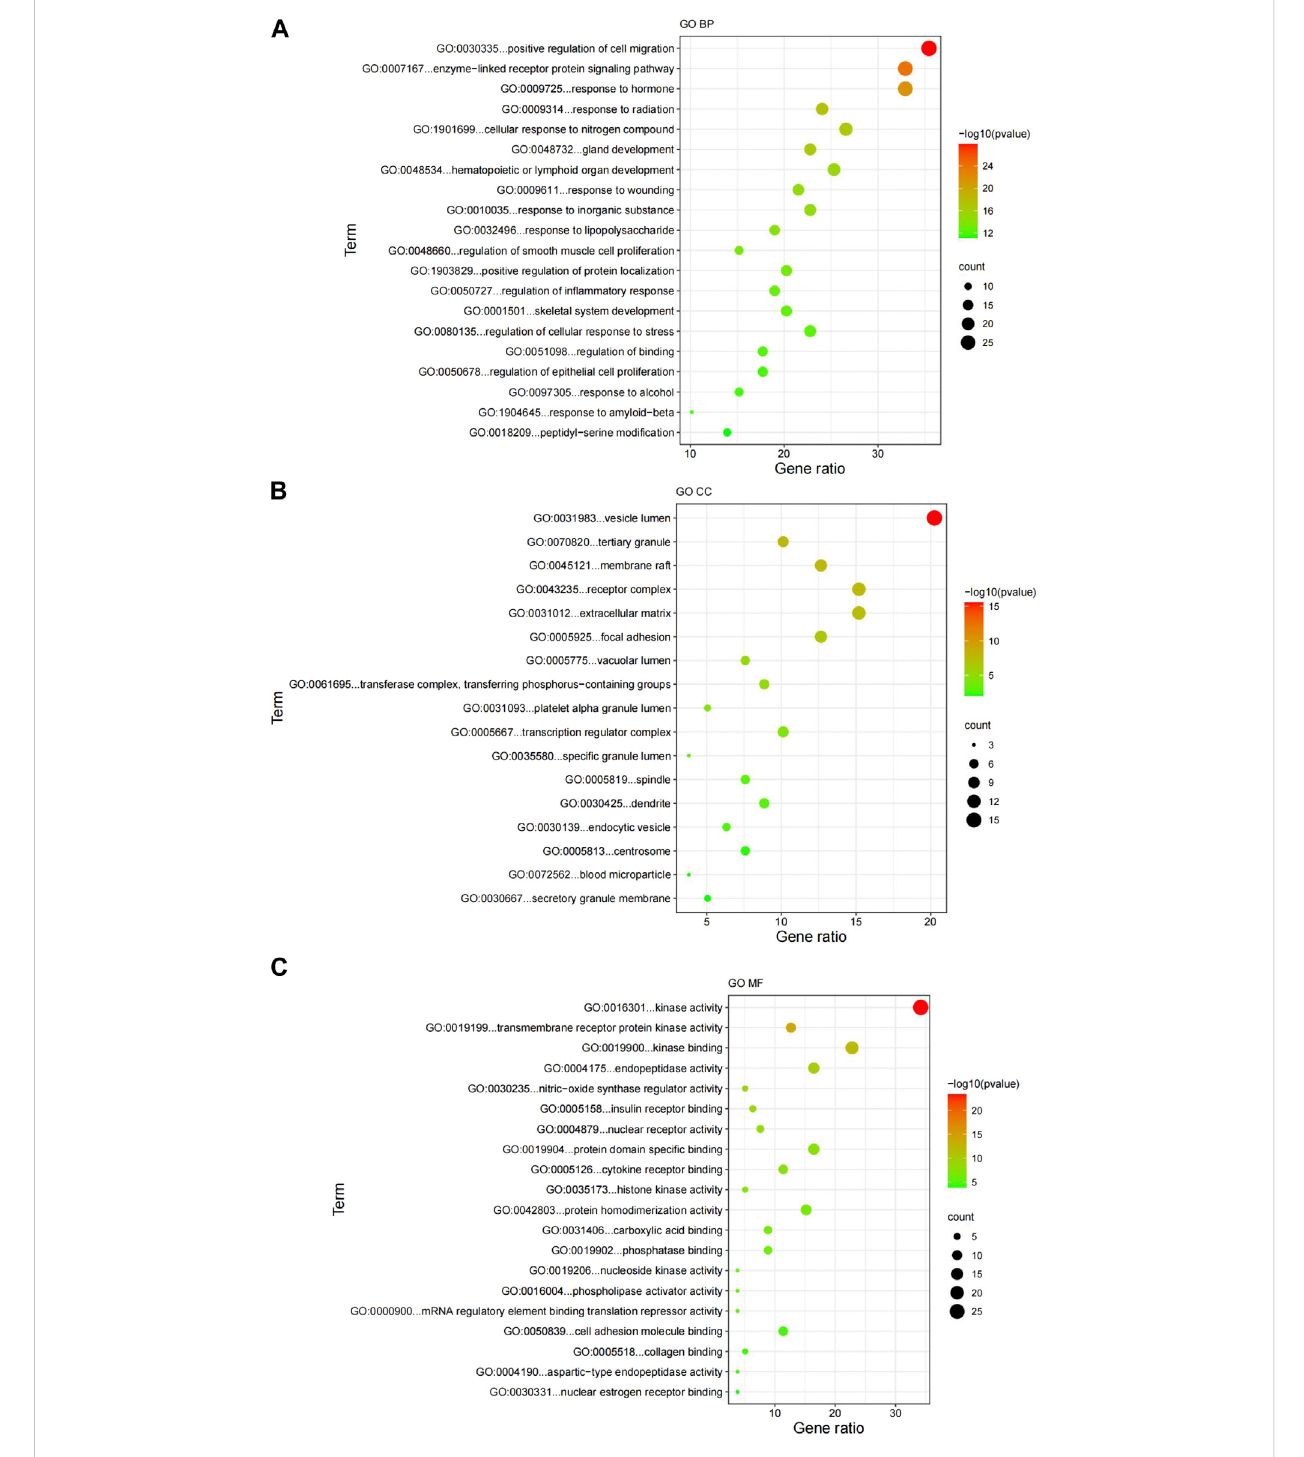
FIGURE 5 Results of the GO enrichment analysis. (A) GO biological processes; (B) GO cellular components; (C) GO molecular functions. GO, Gene Ontology; BP, biological processes; CC, cellular components; MF, molecular